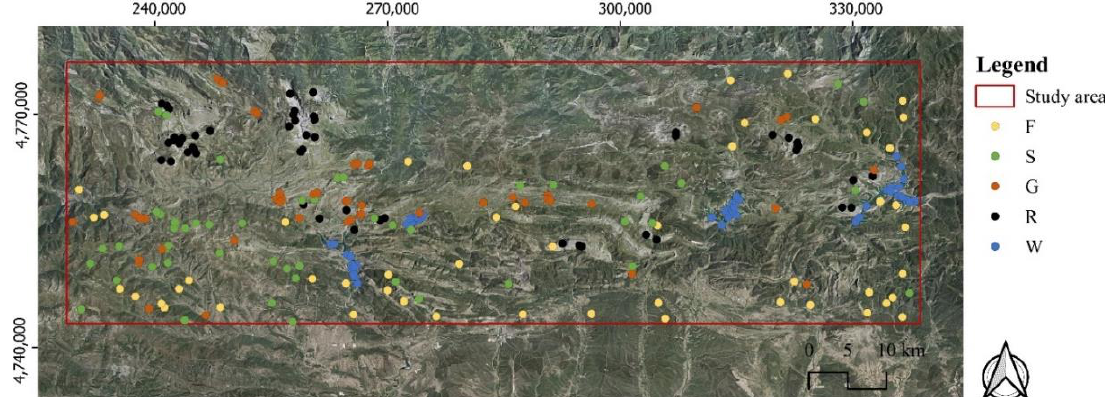
Figure 4. Distribution of the 50 plots that represent five habitat types in the study area: forest (F), shrubland (S), grassland (G), rock and bare soil (R), and water (W). From the sample of 250 30 × 30 m plots, libraries were generated with the “Spectral Library Tool” plugin for QGIS 3.14 software [30]. The input data for the elaboration of these spectral libraries were the 250 previously generated 30 × 30 m plots of and the satellite image for each year. The operation of the indicated plugin consists of generating the centroid of the inserted polygons and extracting the reflectance value of each pixel for each of the bands of the satellite images. The generated spectral libraries are described